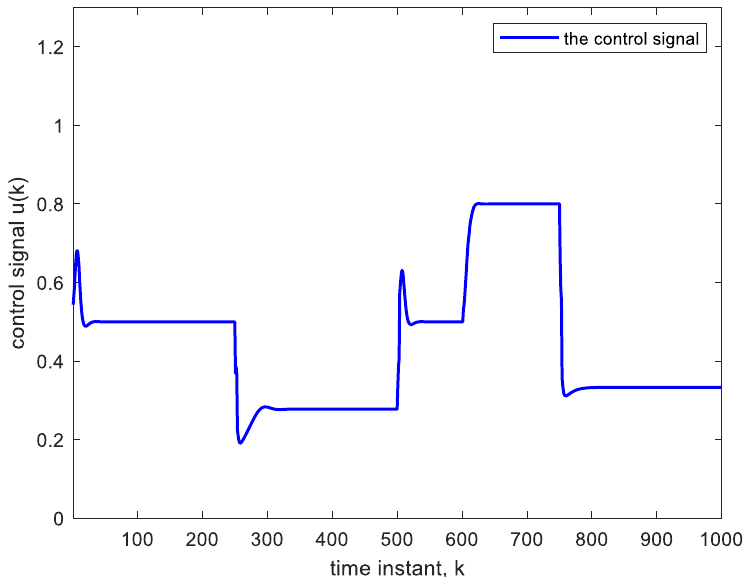
Figure 7. Control signal corresponding to Figure 6.